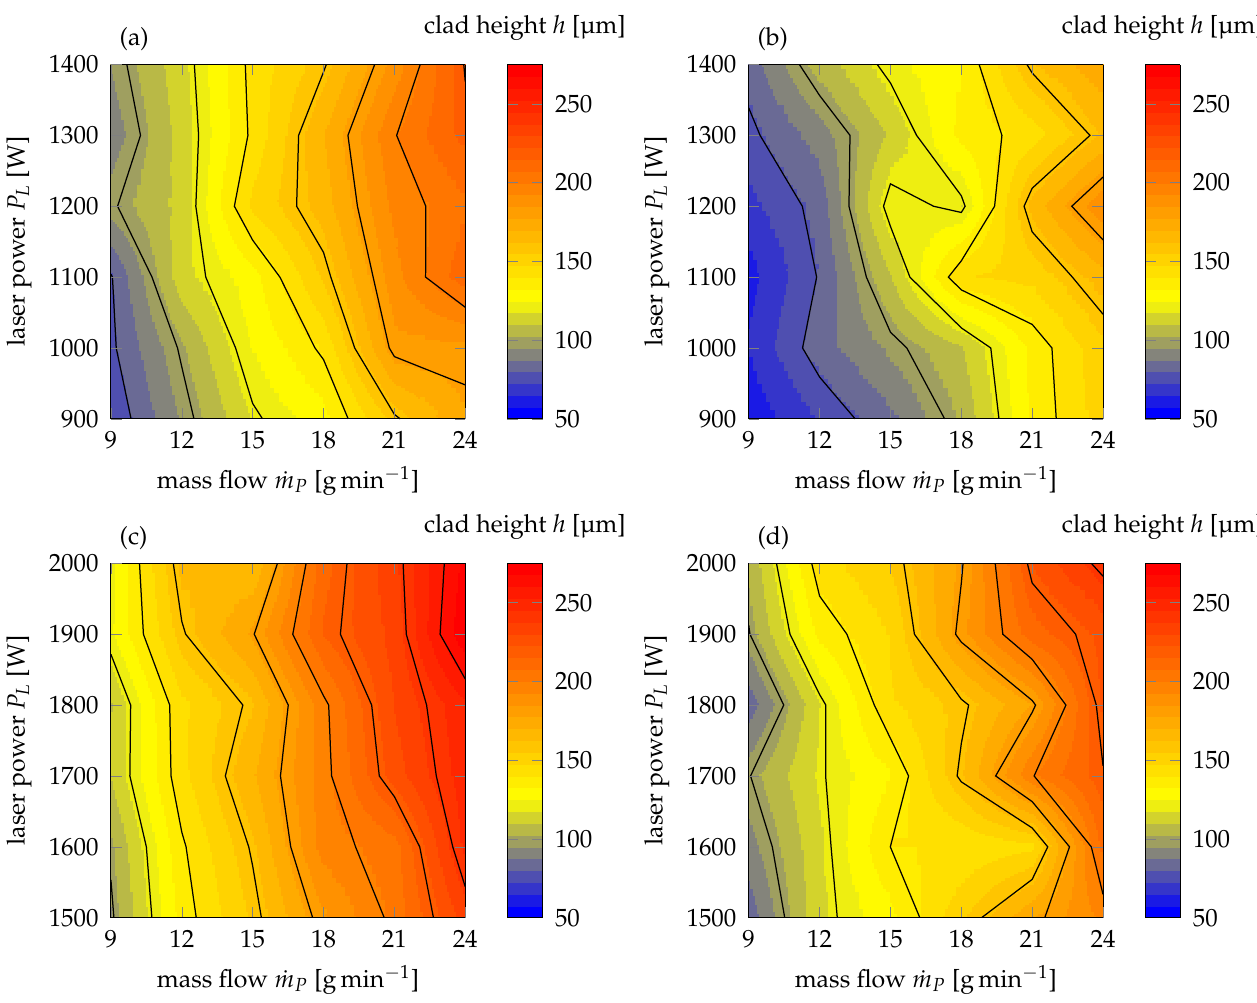
Figure 6. Development of clad height h in dependence on laser power P L and mass flow ˙ m P . Top: laser beam diameter 800µm, bottom: laser beam diameter d L d L ≈